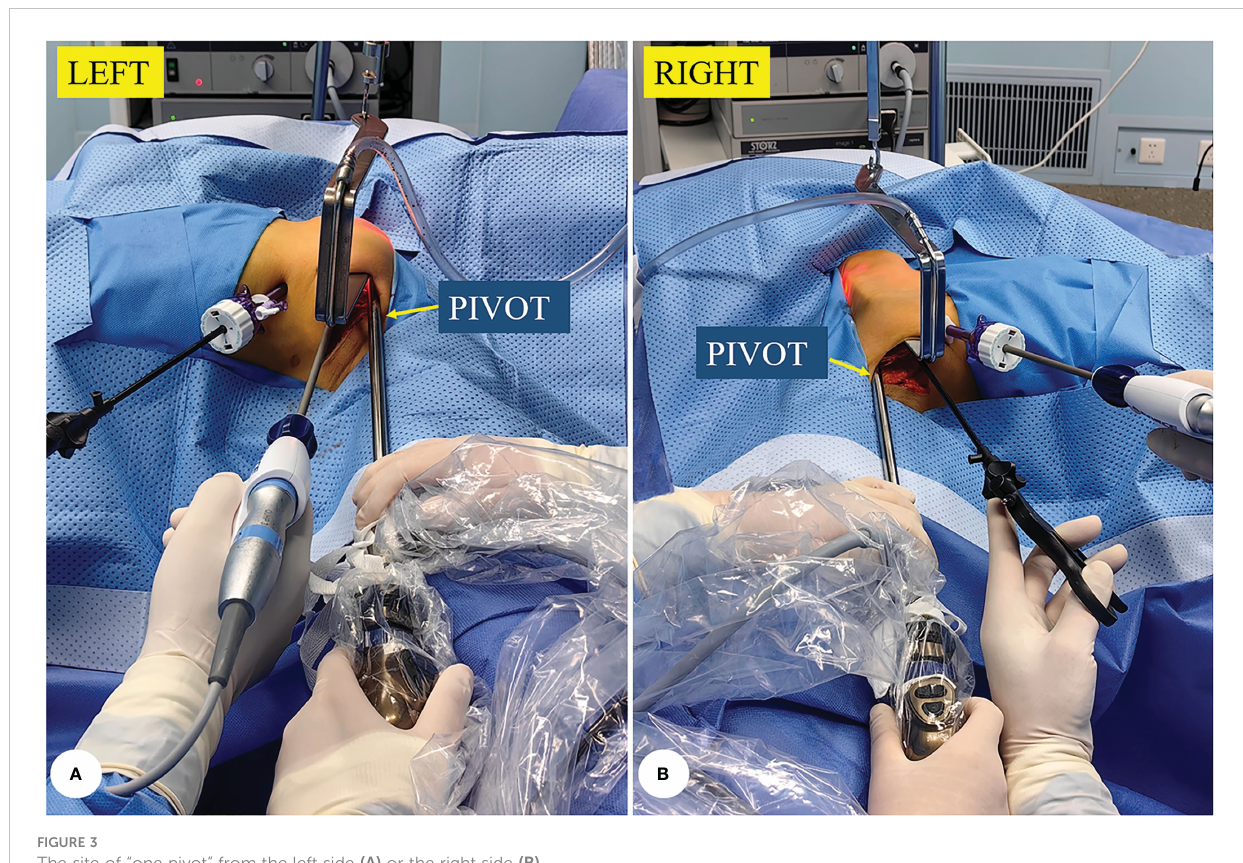
FIGURE 3 The site of “ one pivot ” from the left side (A) or the right side (B)